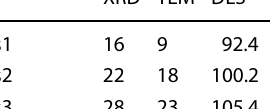
Fig. 12 DLS plots of Au/Ag BNPs produced by laser ablation technique Table5 The size of BNPs obtained from XRD, TEM and DLS analysis